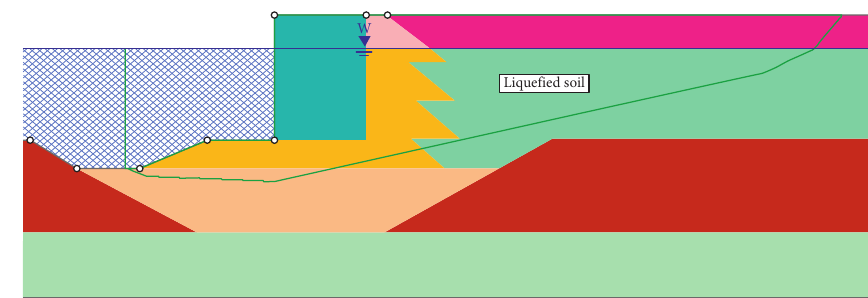
Figure 14: Yield acceleration calculation based upon the soil profile by Yang [36]. Table 8: Newmark displacement analysis results by the simplified method (the reported displacement is reported as